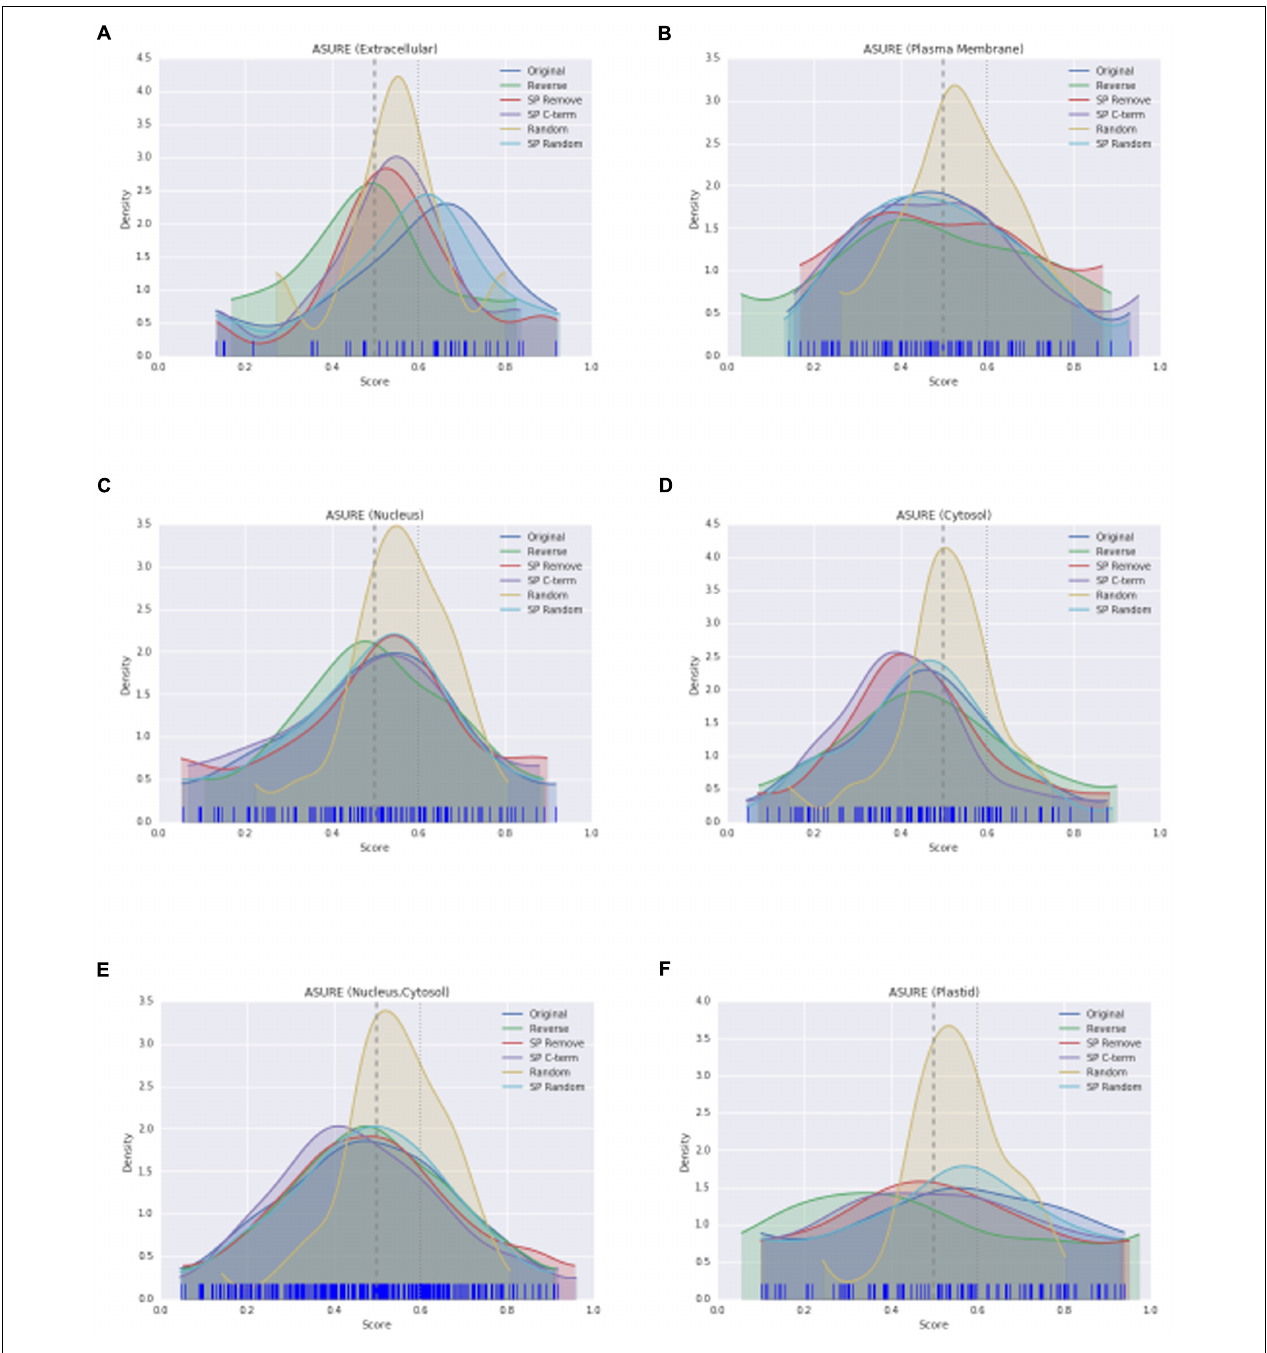
FIGURE 4 | The KDE distributions of SecretomeP scores (as described in Figure 3A) for protein sub-sets of ASURE. Extracellular (A) , plasma membrane (B) , nucleus (C) , cytosol (D) , nucleus and/or cytosol (E), and plastid (F) , respectively.